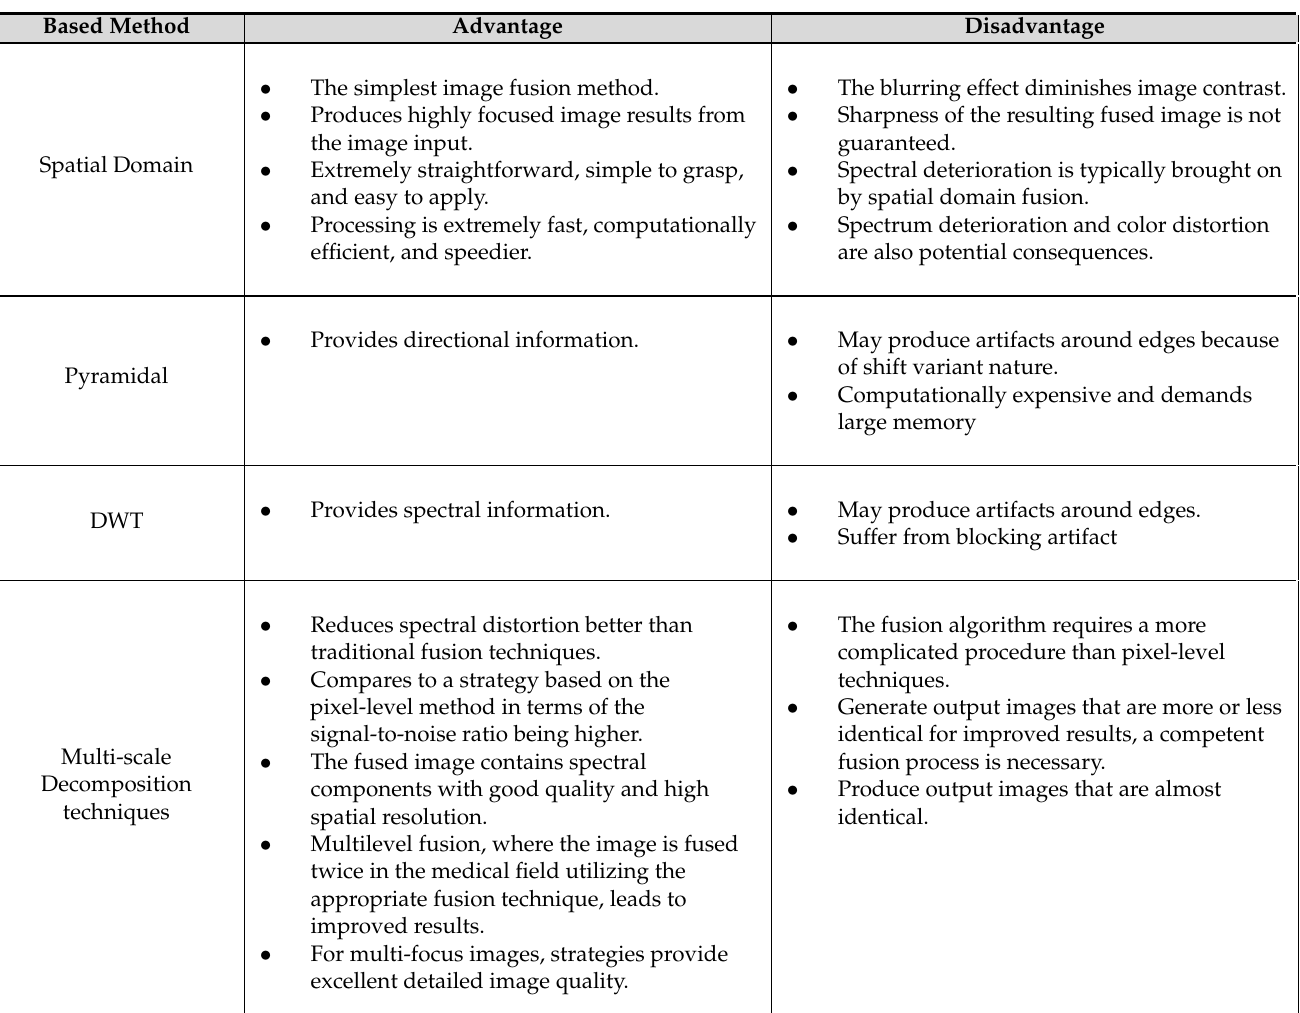
Table 3. Advantages and disadvantages of MMIF